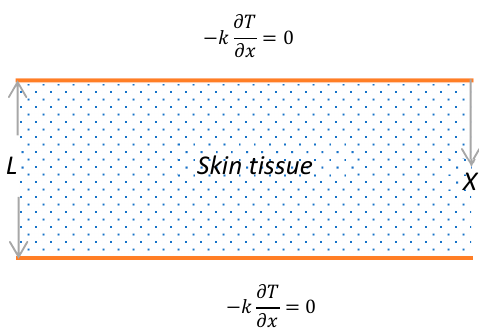
Figure 1. One-dimensional schematic geometry of